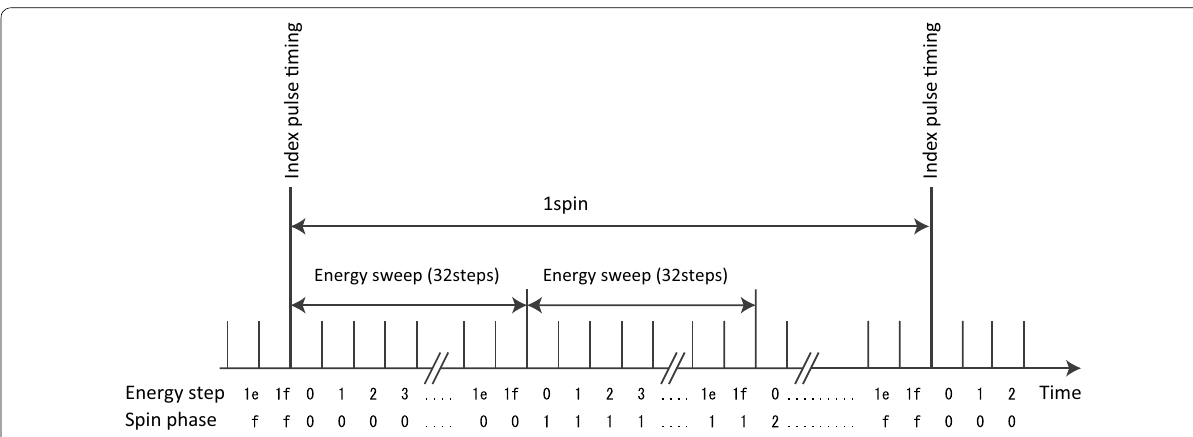
Fig. 9 Measurement timing of LEPi with the index pulse. Spin phase is determined by the reception timing of the index pulse